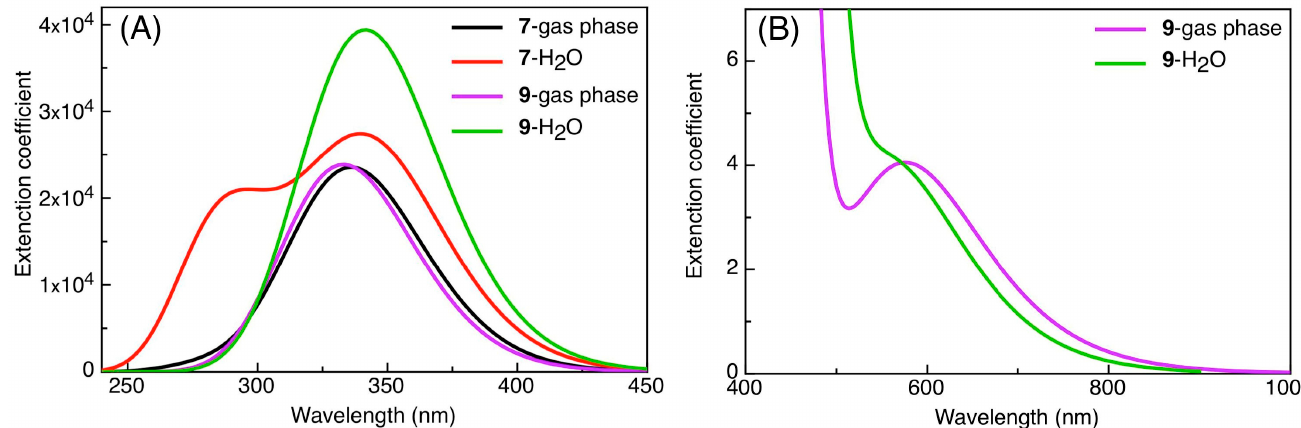
Figure 3. ( A ) Simulated absorption spectra of compounds 7 and 9 calculated by TD-DFT in the gas phase and H 2 O, ( B ) Simulated absorption spectra of 9 in the gas phase and H 2 O at longer wavelength